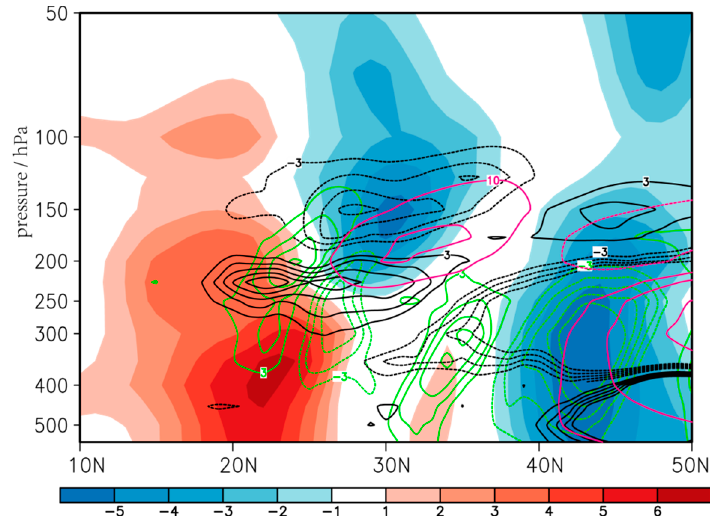
Figure 2. Zonal mean temporal variation of zonal wind (shaded; unit: m ⋅ s − 1 ⋅ day − 1 ), eddy heat flux (pink contours; interval: 10 K ⋅ m ⋅ s − 1 ), and local Eliassen–Palm flux divergence (green contours representing the horizontal component and black contours representing the vertical component; interval: 2 m ⋅ s − 1 ⋅ day − 1 ) between 50°E and 70°E from 10 to 13 March 2006.